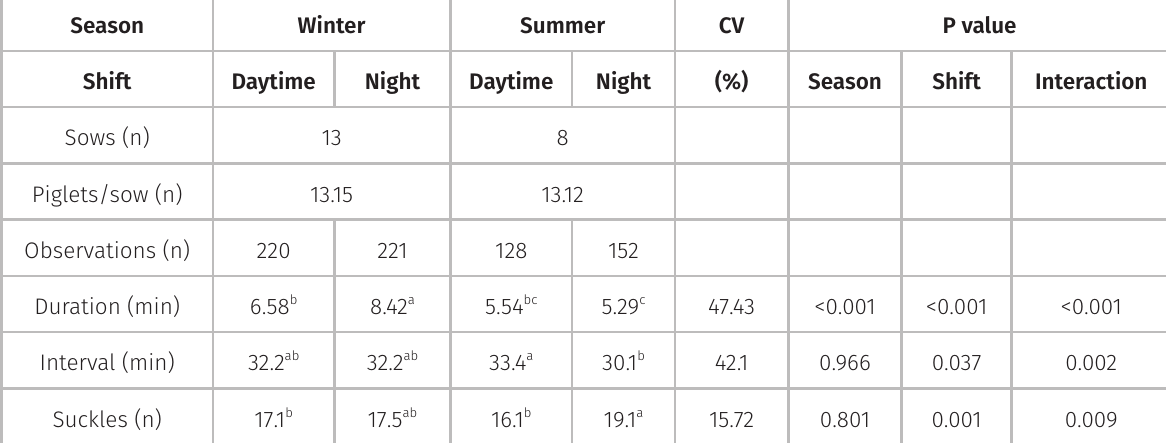
Table II. Behavior of suckling piglets according to the season and shift of the